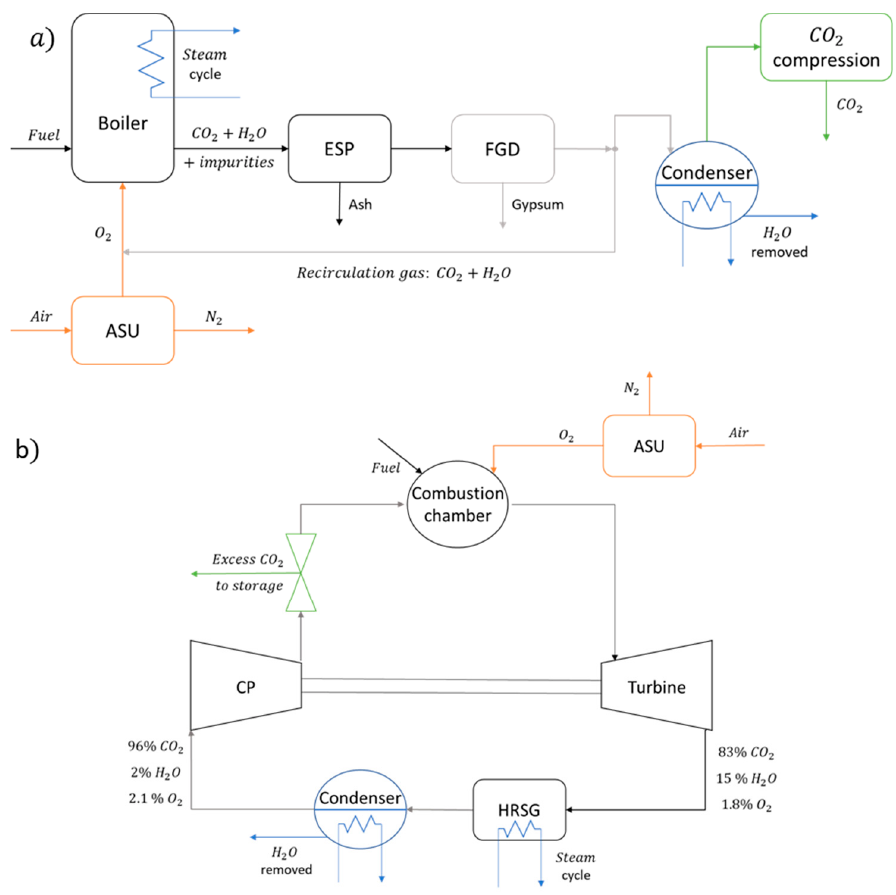
Figure 3. ( a ) Oxyfuel combustion in the Circulating Fluidised Bed (CFB) reactor with CO 2 recircu- lation coupled with Rankine cycle (secondary cycle); ( b ) gas turbine cycle with CO 2 recirculation (direct cycle). In both plants, the storage receives near pure excess of CO 2 [24].